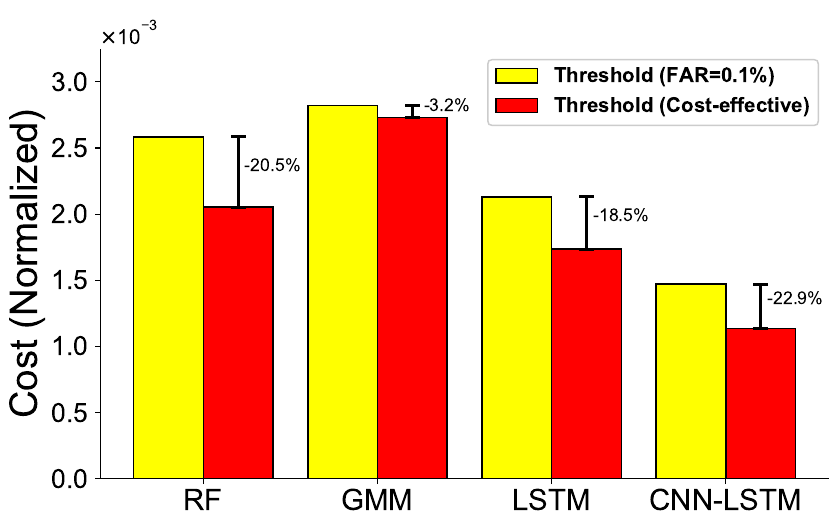
Figure 12. Comparison of normalized cost between fixed threshold (FAR = 0.1%) and cost- effective threshold.